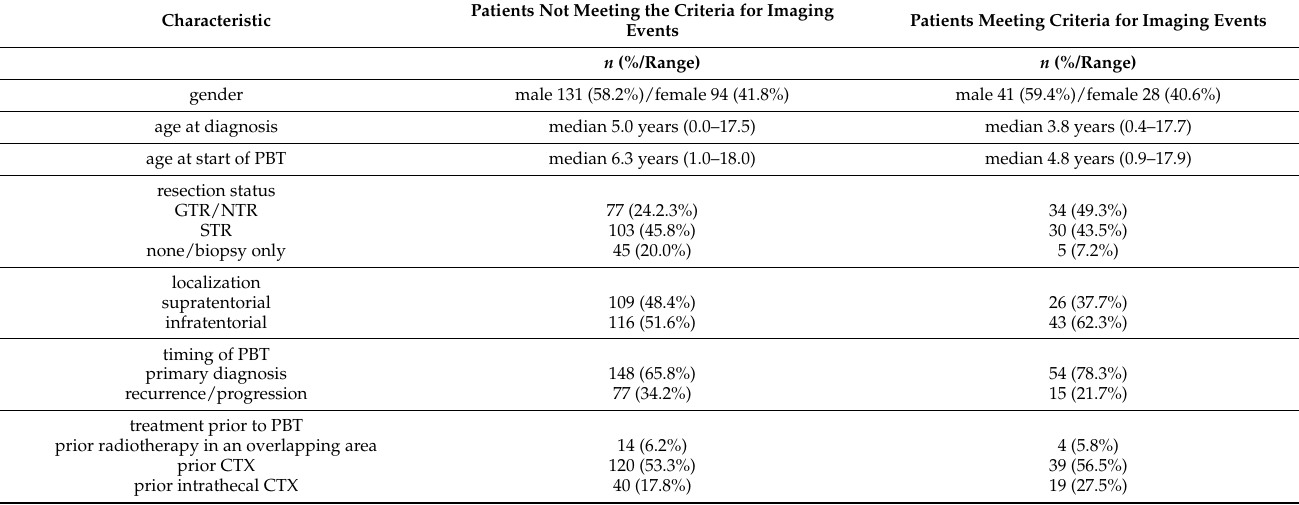
Table A3. Patient characteristics and treatment data of subgroups divided by meeting the criteria for imaging